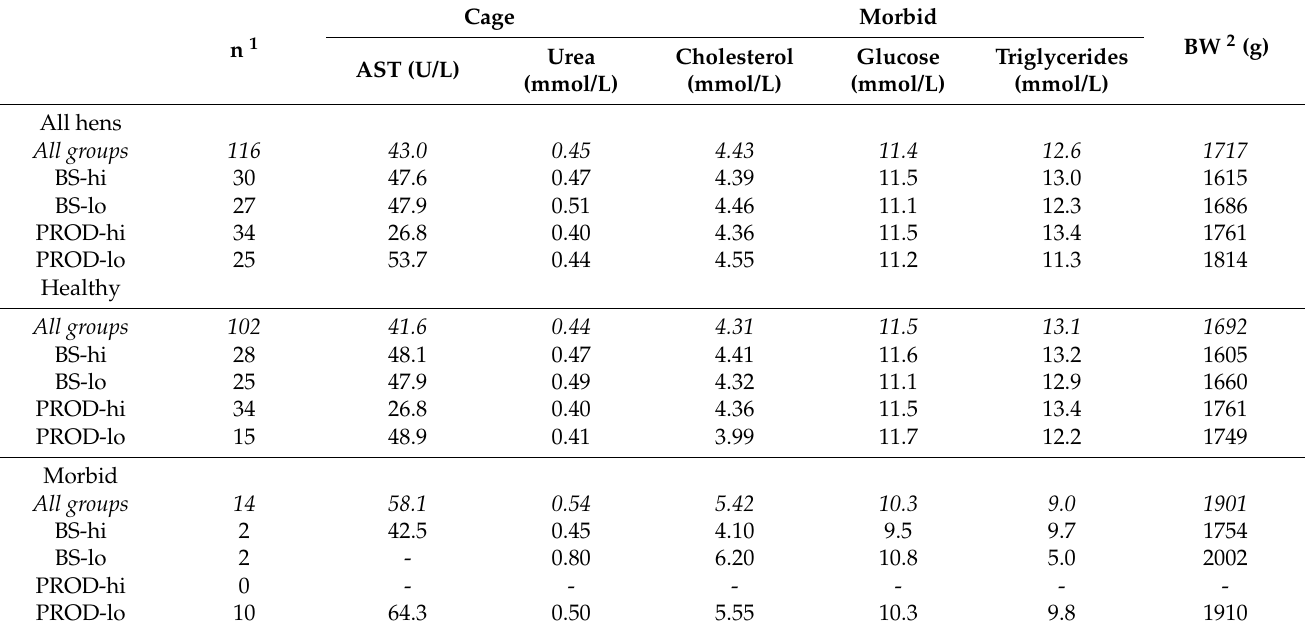
Table 2. Means of significant metabolites and body weight for all hens per healthy and morbid